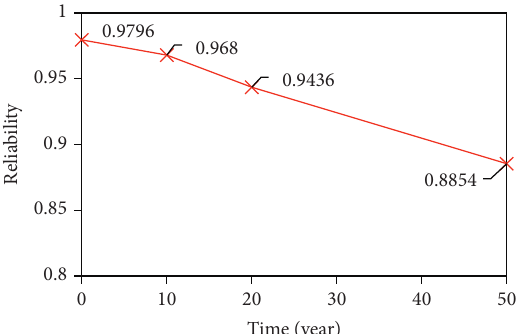
Figure 16: Variation of reliability of SCC beams with service time.